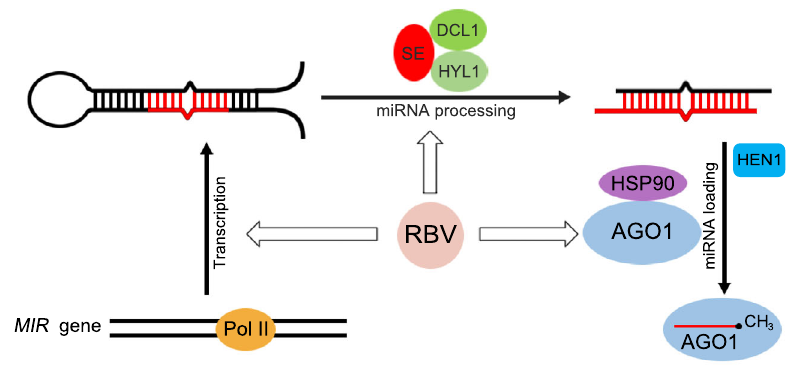
Fig. 7 A model for the role of RBV in miRNA biogenesis. A pathway of miRNA biogenesis entailing MIR gene transcription, pri-miRNA processing, miRNA methylation, and miRISC formation is shown. Key protein players in each step are depicted as ovals. RBV promotes miRNA biogenesis at the MIR gene transcription and AGO1 loading steps and may also enhance pri-miRNA